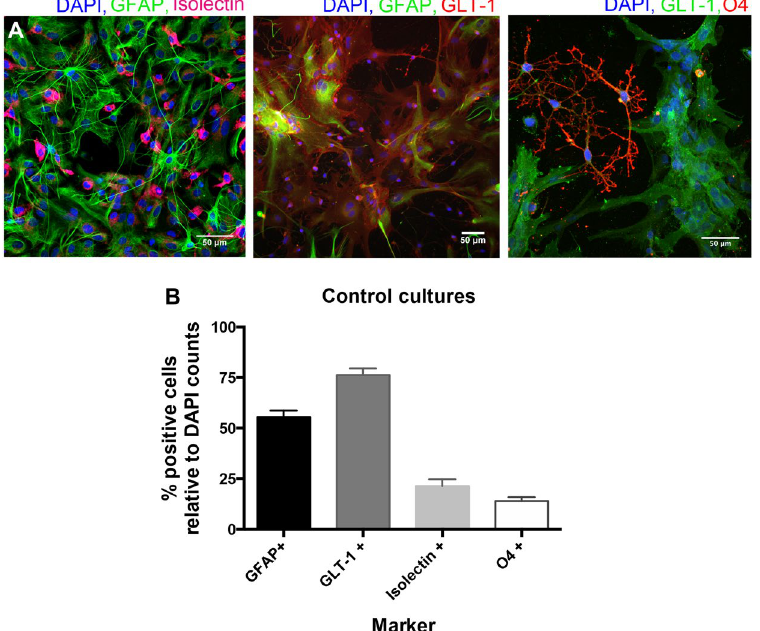
Figure 1. Characterisation of the cell populations present in the mixed glial cell cultures. Cells were stained for GFAP and GLT-1 (astrocyte markers), Isolectin (microglia marker) and O4 (oligodendrocyte marker). Representative images are shown in ( A ); total cell counts with the distribution of cell types is shown in ( B